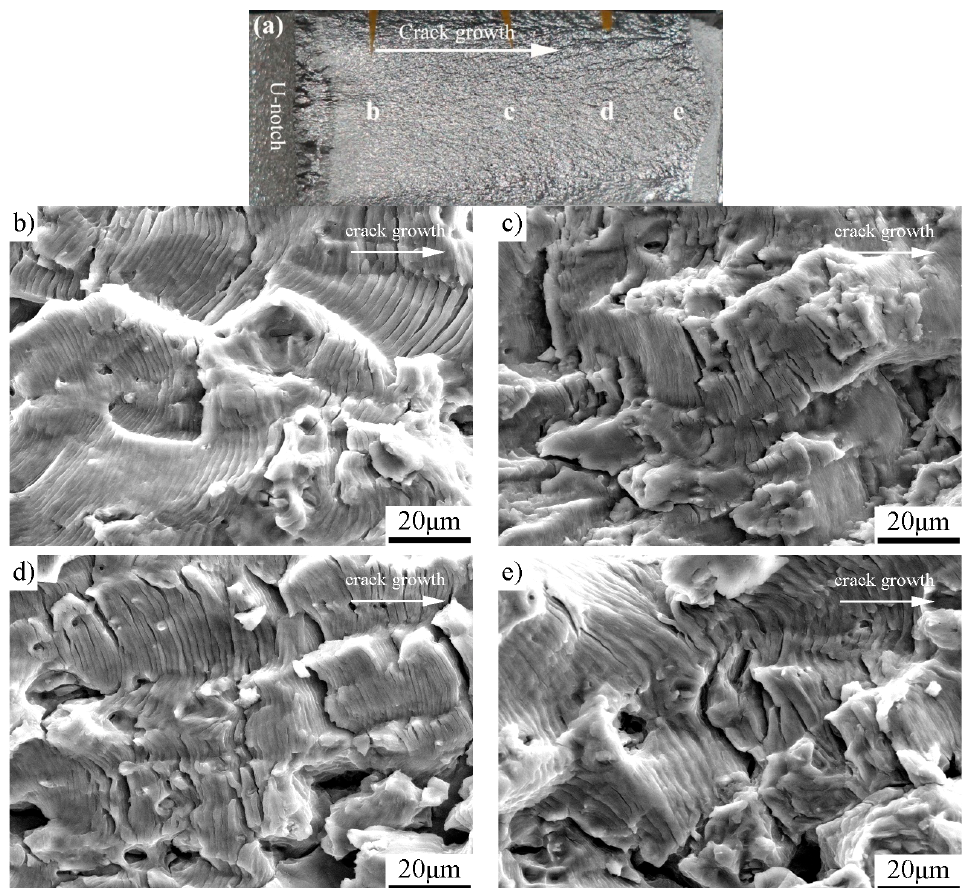
Figure 6. The pre-stressed specimen with pre-stress of 137 MPa: ( a ) macrograph showing the detailed SEM locations; ( b ) Δ K app ≈ 20 MPa √m (striation spacing ≈ 0.3 μ m); ( c ) Δ K app ≈ 30 MPa √m (striation spacing ≈ 1.7 μ m); ( d ) Δ K app ≈ 40 MPa √m (striation spacing ≈ 3.8 μ m); and ( e ) unstable propagation zone (striation spacing ≈ 4.7 μ m).